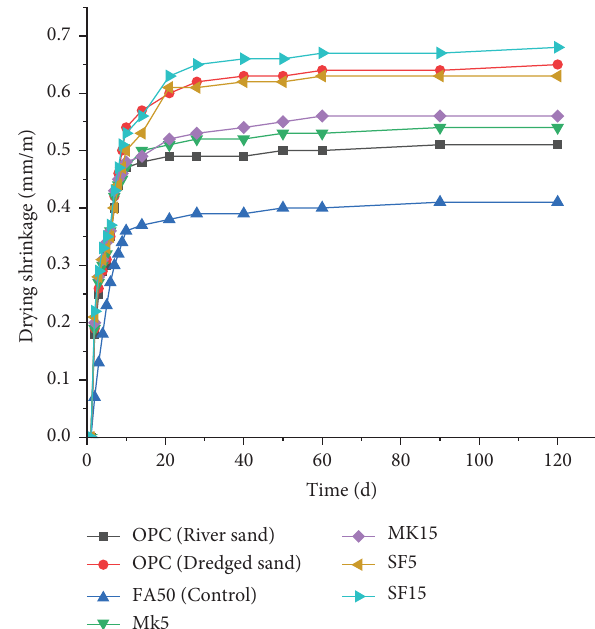
Figure 6: Drying shrinkage of